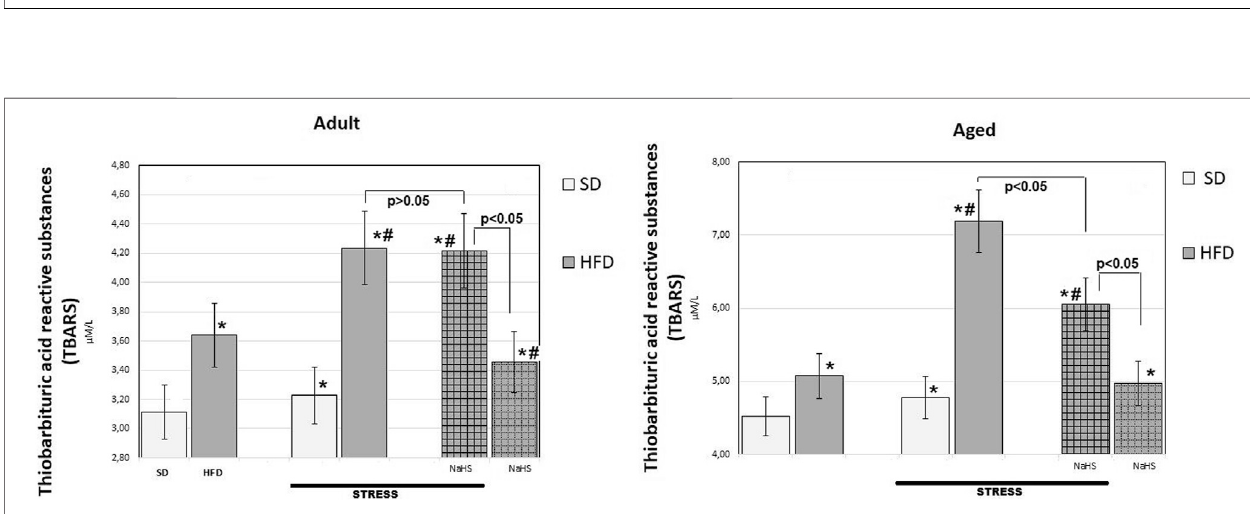
Frontiers in Pharmacology |